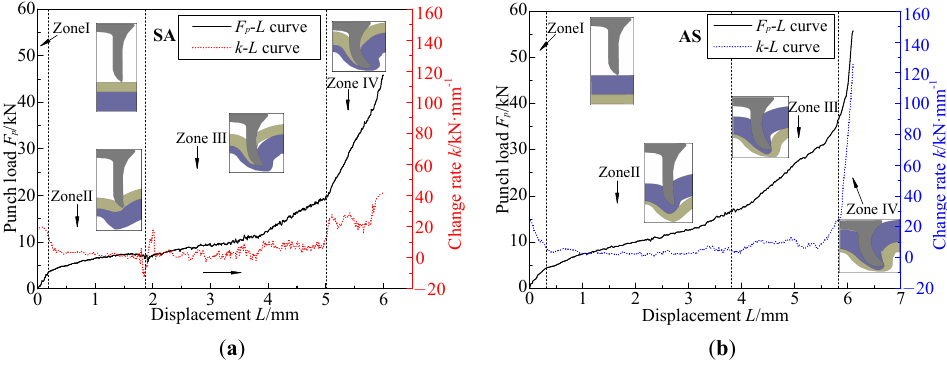
Figure 4. The F p - L curve and k - L curve of ( a ) the SA joint and ( b ) AS joint. Expansion stage: the rivet penetrated the upper sheet and then gradually pierces into the lower sheet. In this stage, the plastic deformation and work hardening occur in the lower sheet, resulting in large shear resistance in the vertical direction, as the rivet tip moves along the direction of the least resistance and more obvious expansion occurs [40] (Zone